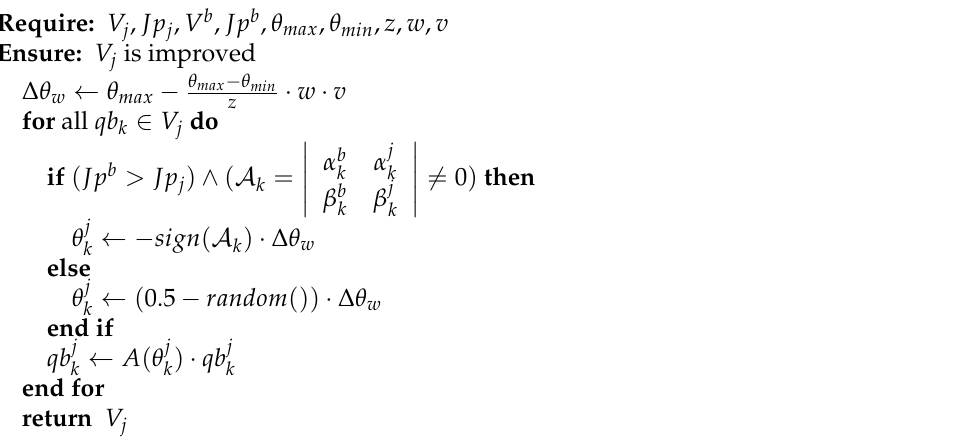
Algorithm 1 Function Improve ( V j , Jp j , V b , Jp b , θ max , θ min , z , w , v )